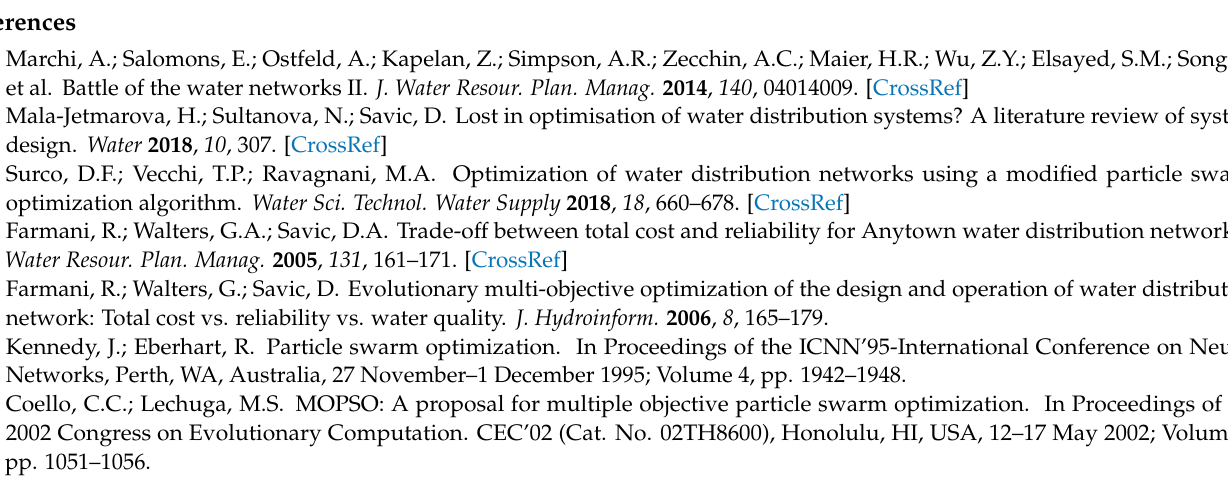
Figure A2. Pseudo-code of the MMOPSO algorithm in a single